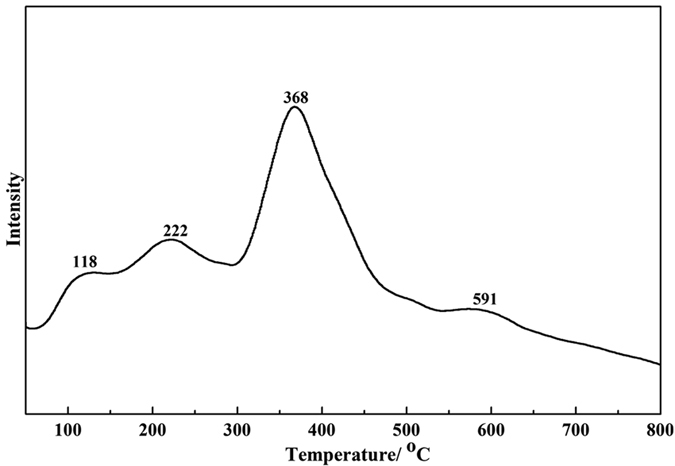
NH3-TPD before reaction.